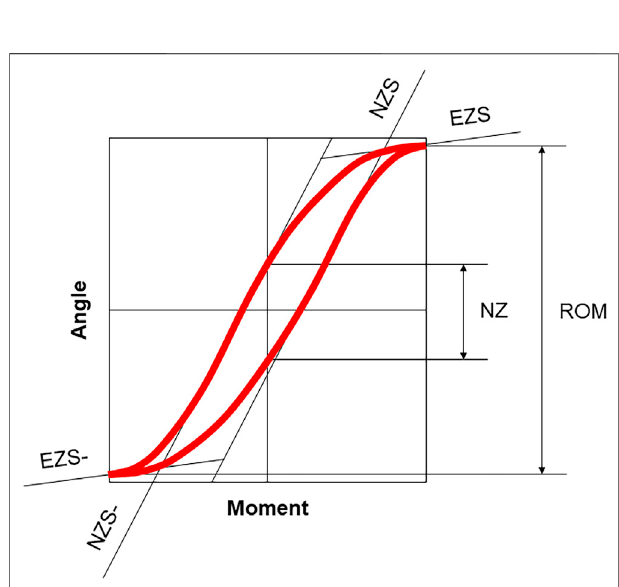
FIGURE 2 | Moment-angle diagram modi fi ed after Wilke et al. (1998), illustrating the quasi-static outcome parameters evaluated in this review. The range of motion (ROM) characterizes the angular displacement under de fi ned loading in one motion direction or within one motion plane, neutral zone (NZ) describes the angular displacement at a relatively low loading in one motion direction or within one motion plane and is a measure of laxity; neutral zonestiffness(NZS)isde fi nedasmomenttoangleratiointheneutralzoneand characterizesthelaxdeformation,andelasticzonestiffness(EZS)isde fi nedas momenttoangleratioin theelastic zone measured from theend oftheneutral zone to the point of maximum loading and describes the elastic deformation, whereas stiffness, in general, is a measure of mechanical resistance. The positive and negative stiffness parameters were averaged in this review,